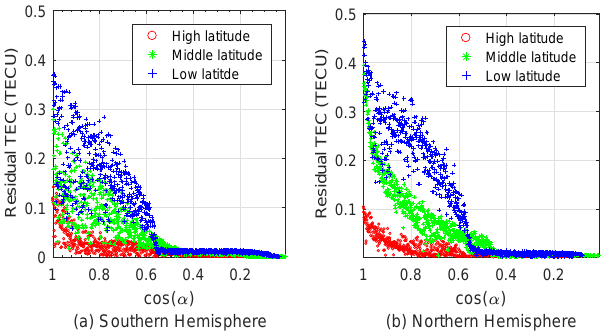
Figure 7. High-order ionospheric residual TEC along the signal path during 18:00–02:00LT (red circles), 02:00–10:00LT (green stars) and 10:00–18:00LT (blue plus). The x axis is the absolute cosine value of RO azimuth, and the y axis is the absolute value of residual TEC. The lines are the average value of residual TEC in different RO